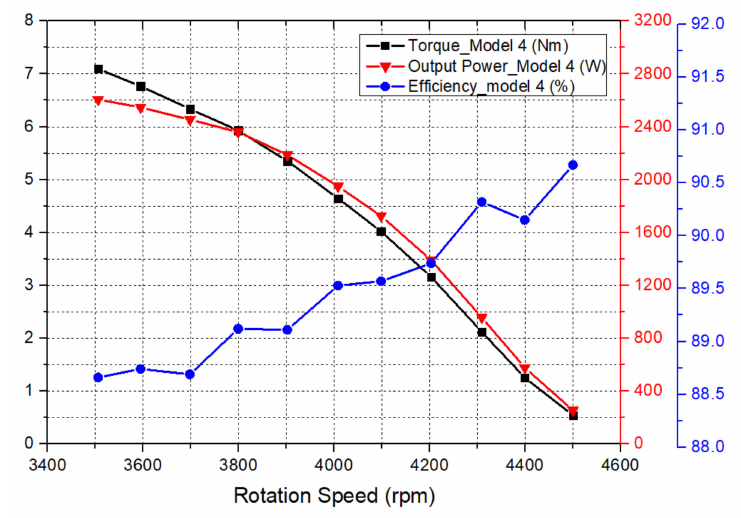
Figure 3. Electromagnetic field analysis result of the IPM